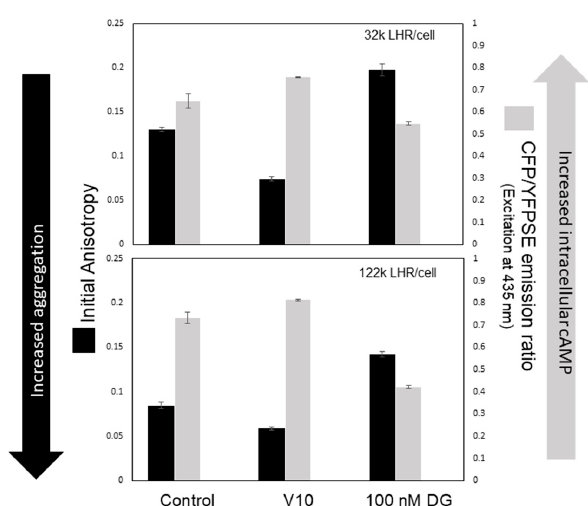
Figure 5. Comparison of the extent of LHR aggregation in cells expressing physiologically relevant receptor numbers (32 k LHR/cell) and cells overexpressing LHRs (122 k LHR/cell). The extent of receptor aggregation was measured as a function of receptor anisotropy (Y-axis, left). Decreased anisotropy values indicate more extensive clustering of the receptor, as shown by the arrow. The extent of receptor clustering was compared to intracellular cAMP levels (Y-axis, right) measured using a cAMP probe. In some experiments, cells were pre-treated with decavanadate (V10), which reduced the extent of membrane lipid packing (data not shown) while causing increased clustering of LHRs and increased cAMP [125]. Pre-treatment of cells with 100 nM deglycosylated hCG (DG), reduced receptor clustering, and reduced cAMP signaling. Both homo-FRET results and intracellular cAMP levels are expressed as mean ±SEM of 30 measurements for each condition. Statistical evaluation of mean differences in untreated and treatment groups was analyzed by one-way ANOVA followed by the Tukey multiple comparison test and Student’s t- test to compare between two groups using R version 3.3.1. p -values < 0.05 were statistically significant.